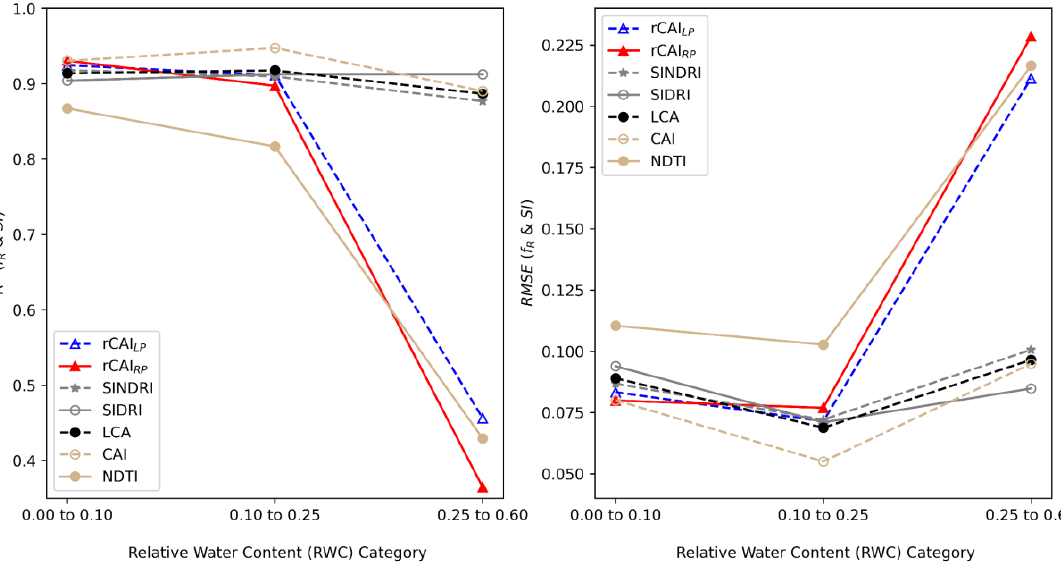
Figure 9. Heritage spectral index (SI) f R estimation performance according to RWC class. Left panel is R 2 and right panel is RMSE .